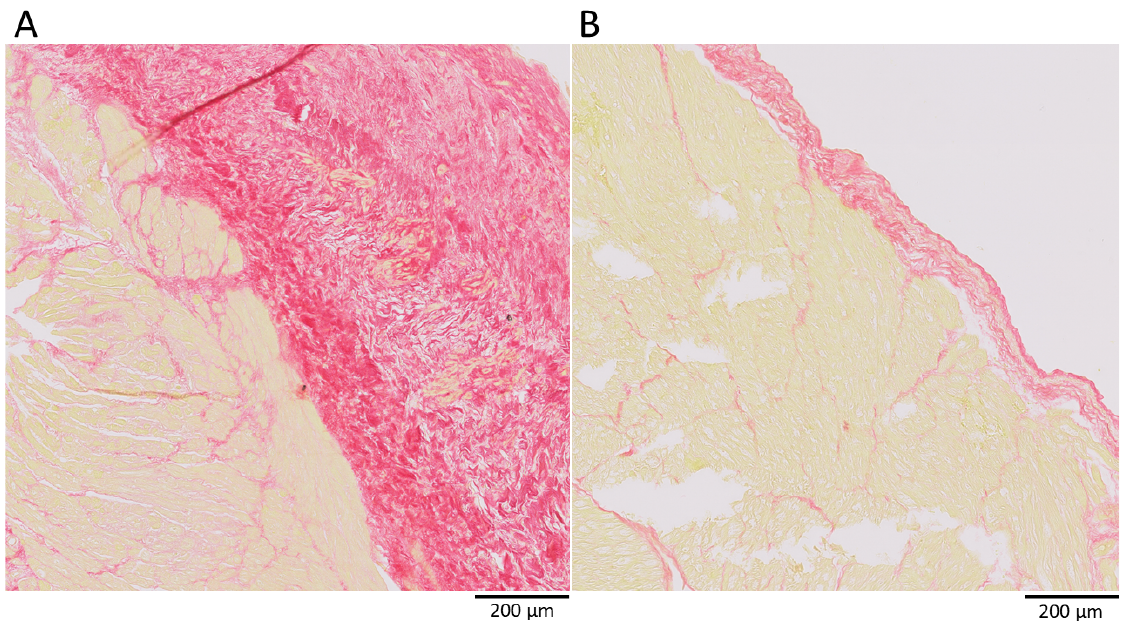
Figure 5. Percentage of collagen in Picrosirius red-stained histologic sections. ( A ) Total percentage of collagen in the histologic sections. ( B ) Percentage of epicardial and endocardial collagen, ( C ) Per- centage of interstitial collagen.